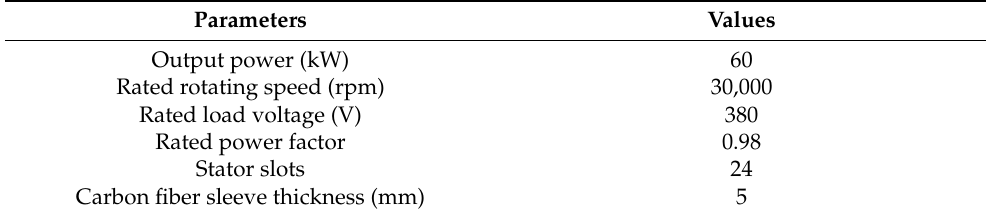
Table 1. Main parameters of the designed motor for HSPMM.